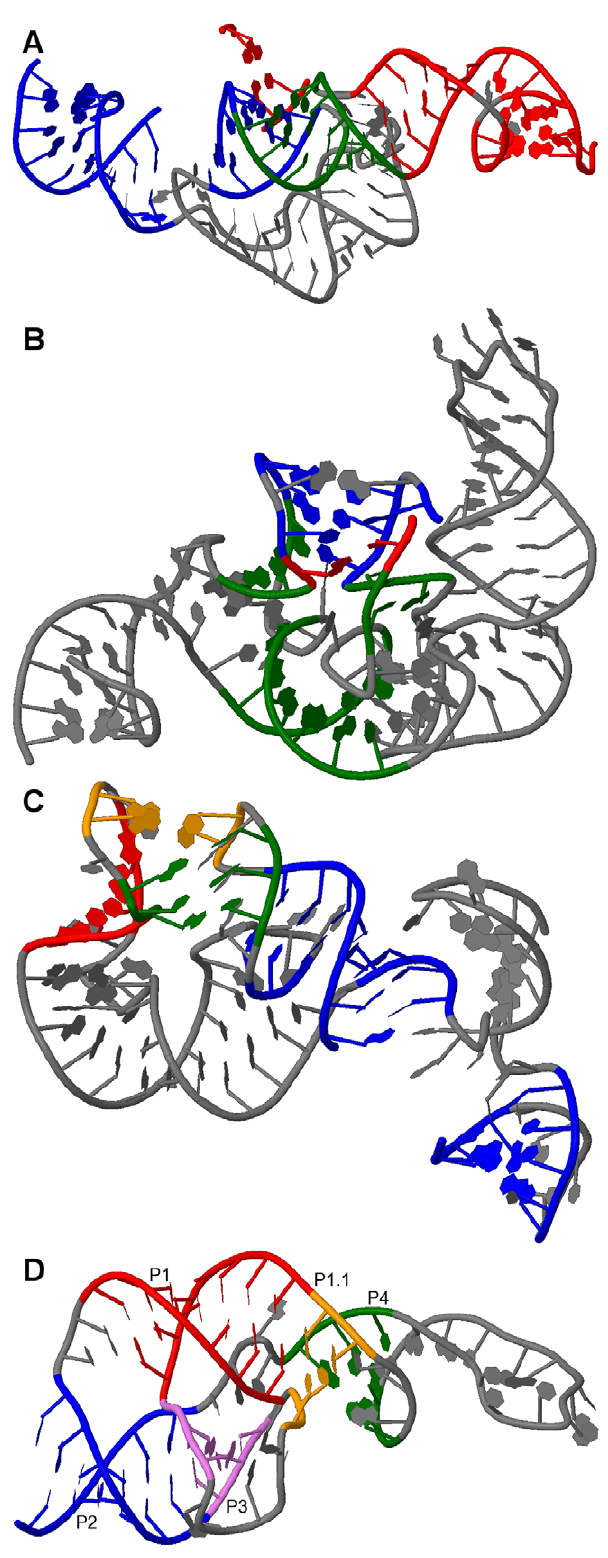
Figure 10. 3D structures for special pseudoknot motifs. A-C were derived from RNA molecule 1S72 ( Haloarcula marismortui) of PDB, and D was derived from 1VC6 ( Hepatitis Delta Virus ). A: Kissing site of the large kissing hairpin. The stems for the interdomain COIN stack are in red and those for intradomain COIN stack are in blue, while